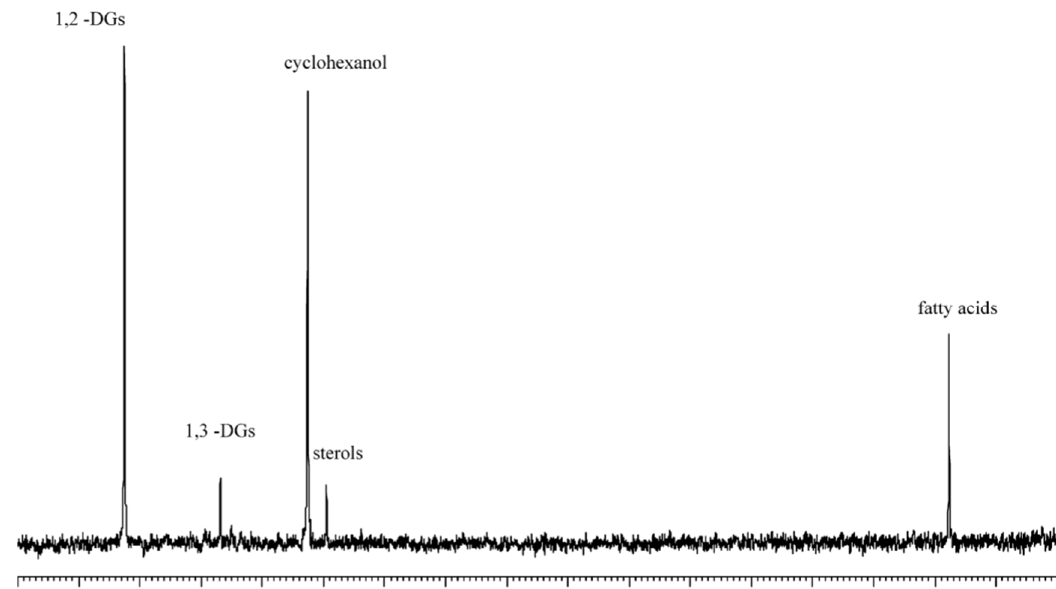
Figure 6. 31 P NMR spectrum of virgin olive oil in pyridine / CDCl 3 , corresponding to the region of phosphitylated total sterols, diglycerides, and free fatty acids. The phosphitylated cyclohexanol is used as internal standard. The spectrum was acquired with inverse-gated decoupling on a Bruker AMX500 spectrometer at room temperature, using 32 scans and 16K data points, with a 90 ◦ pulse and a relaxation delay of 30 s. Reprinted with permission from the Journal of Agricultural and Food Chemistry